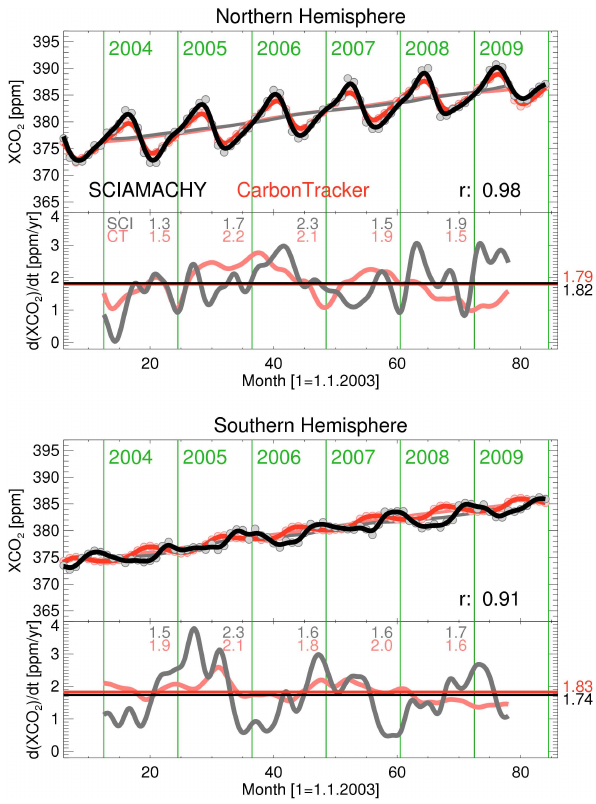
Fig. 3. Comparison of the SCIAMACHY (black) and Carbon- Tracker (red) XCO 2 for the Northern Hemisphere (top) and the Southern Hemisphere (bottom) based on monthly means (coloured circles). The standard error on the SCIAMACHY monthly means is less than 0.1ppm. The saturated solid lines have been smoothed using a four-month Hann window (which has a similar frequency response to a two-month boxcar filter but better attenuation of high frequencies). The pale solid lines represent the correspond- ing deseasonalised trends derived using a 12-month running mean. Shown below are the derivatives of these deseasonalised curves corresponding to the current increase at the considered point in time. Also noted are yearly mean values of the derivatives (in pale colours) as well as the mean value of the whole time period on the right hand side.